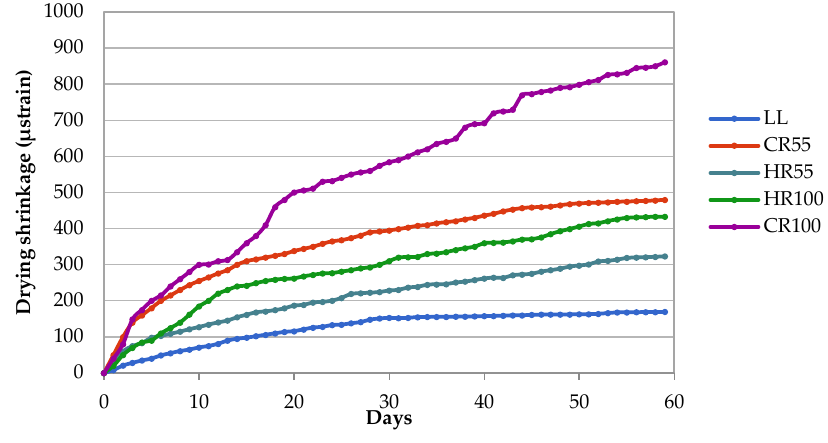
Figure 11. Drying shrinkage of test concretes.